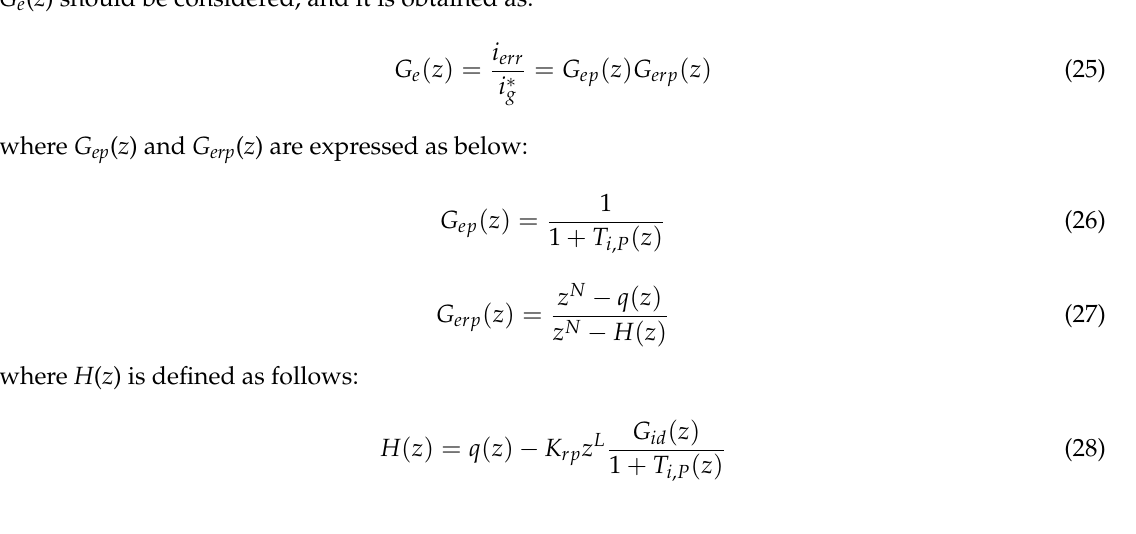
Figure 8. Proposed current controller.